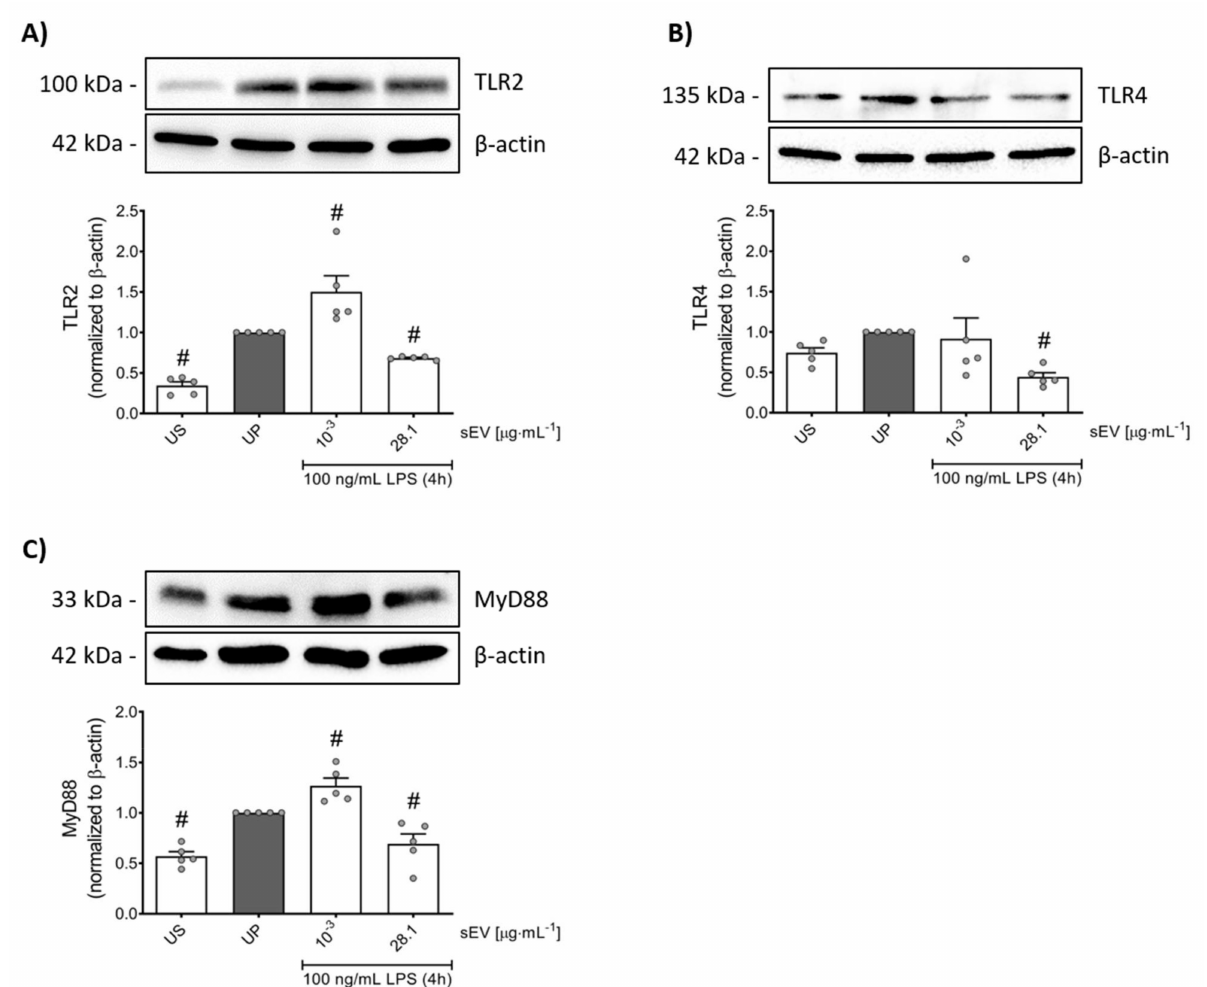
Figure 4. Signaling events behind gut microbiota-derived small EVs in murine neutrophils. Murine bone marrow neutrophils were primed for 45 min by microbiota-derived small EVs (low concen- tration: 1 ng/mL; high concentration: 28.1 µ g/mL) and later, on day 2, were re-challenged by 100 ng/mL LPS for 4 h as described above. Protein expression of TLR2 ( A , n = 5), TLR4 ( B , n = 5) and MyD88 ( C , n = 5) were assayed by Western blotting and quantified (unprimed cells assigned as 1.0). Data are presented as scatter dot plots, mean + SEM, # p < 0.05, # versus unprimed condition (UP, gray